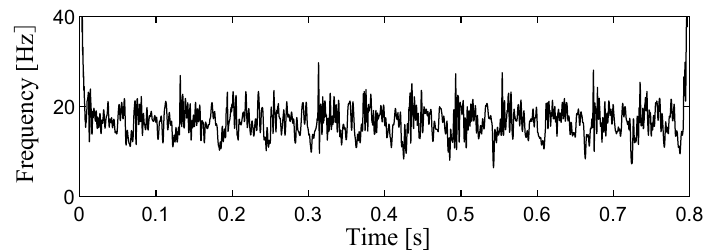
Figure 29. The FFT spectrum of the displacement signal.